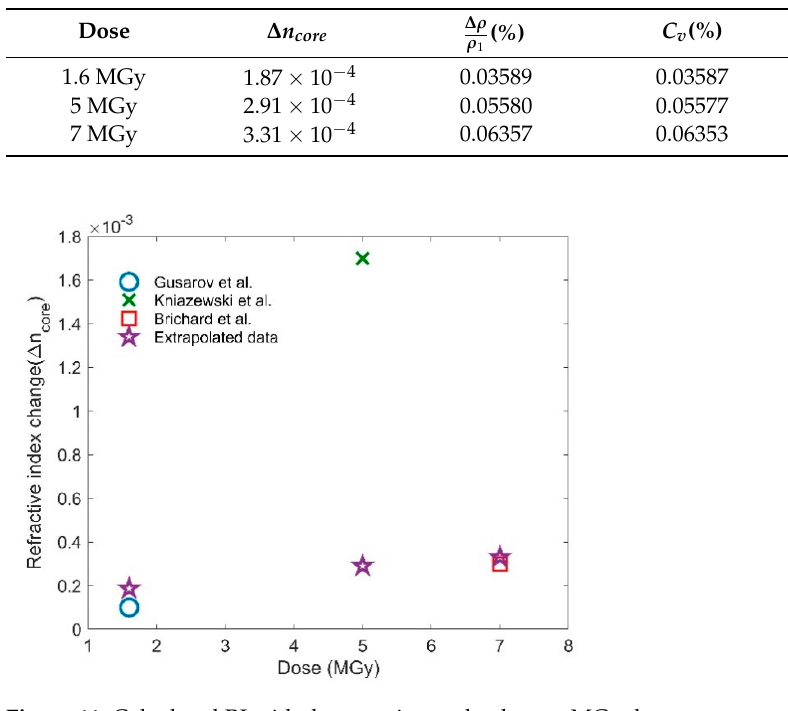
Figure 10. Curve fitting for relative density as a function of dose using the values from Table 2. Table 4. Calculated values for higher doses, as obtained by inputting the fitting constant values from Figure 10 into Equation (6).